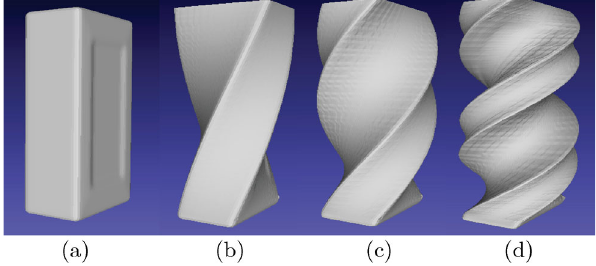
Fig. 13 Twisting. (a) A cuboid mesh. (b)–(d) Twisting is applied to the cuboid. The resulting mesh changes as the twisting degree is